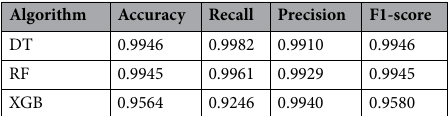
Table 4. Performance evaluation on SMOTE